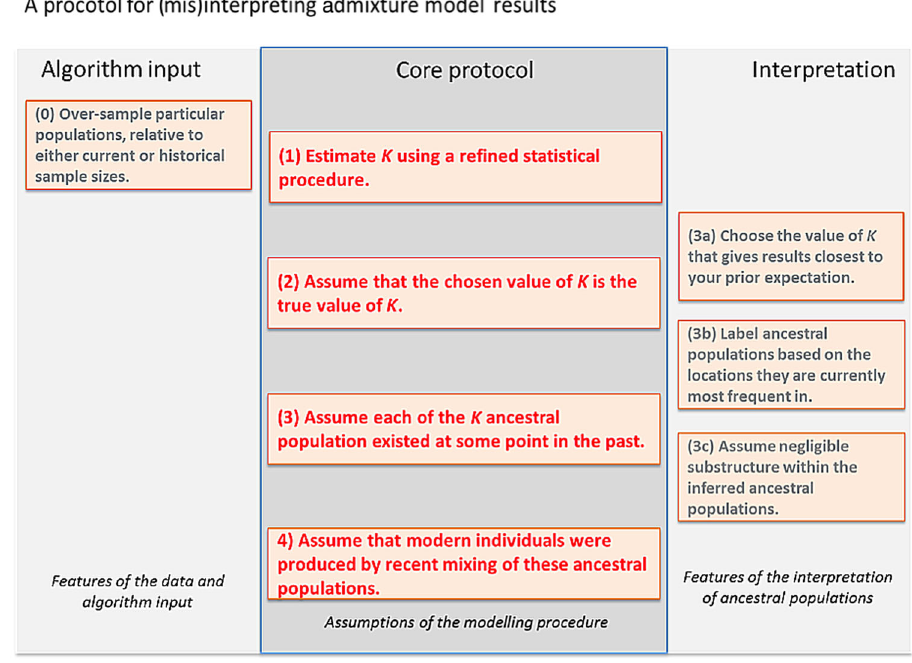
Fig. 1 A protocol for interpreting admixture estimates, based on the assumption that the model underlying the inference is correct. If these assumptions are not validated, there is substantial danger of over-interpretation. The “ Core protocol ” describes the assumptions that are made by the admixture model itself (Protocol 1, 3, 4), and inference for estimating K (Protocol 2). The “ Algorithm input ” protocol describes choices that can further bias results, while the “ Interpretation ” protocol describes assumptions that can be made in interpreting the output that are not directly supported by model